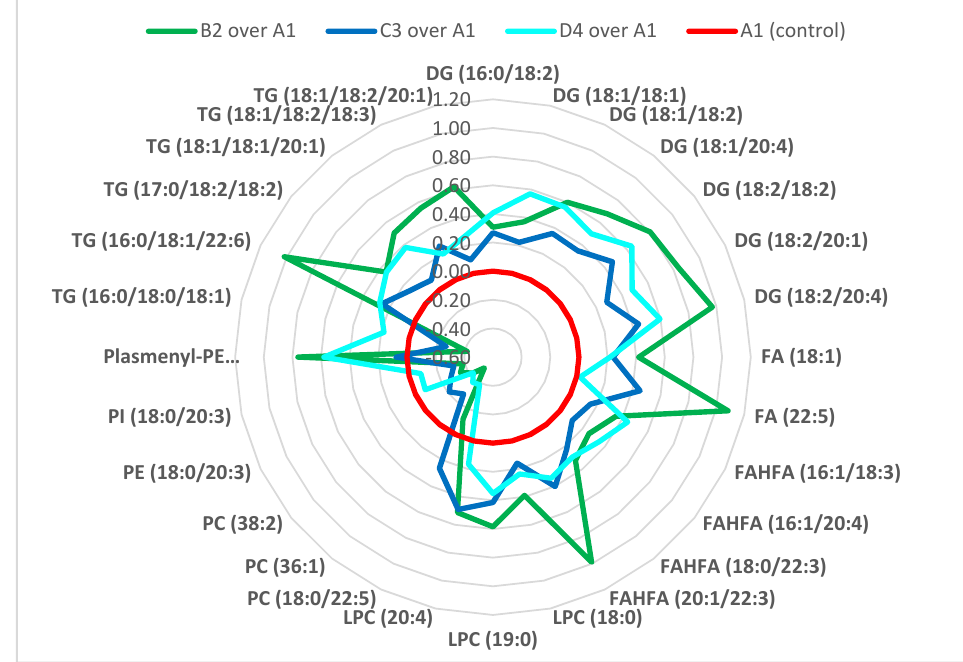
Figure 2. The radar chart of 28 significantly elevated lipids upon exposure to mycotoxins and/or silymarin. Data are expressed as log2(FC) over control. (Lipids with OPLS-DA VIP score > 1 significantly contributing to the group separation in at least two binary comparisons are stated.)